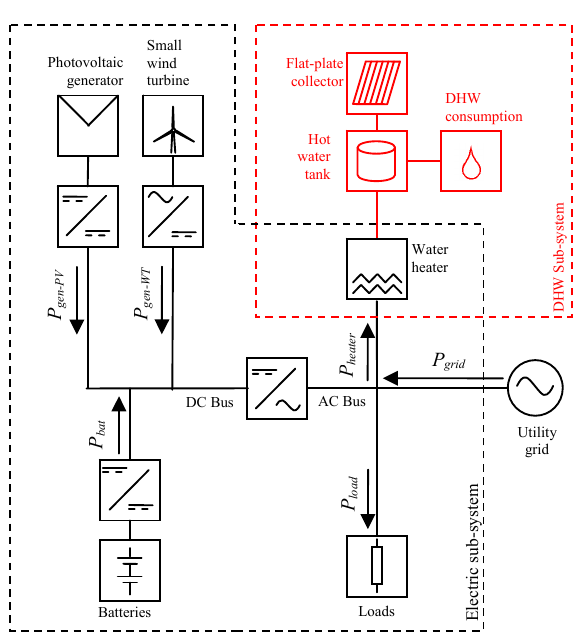
Figure 1. Electrothermal microgrid